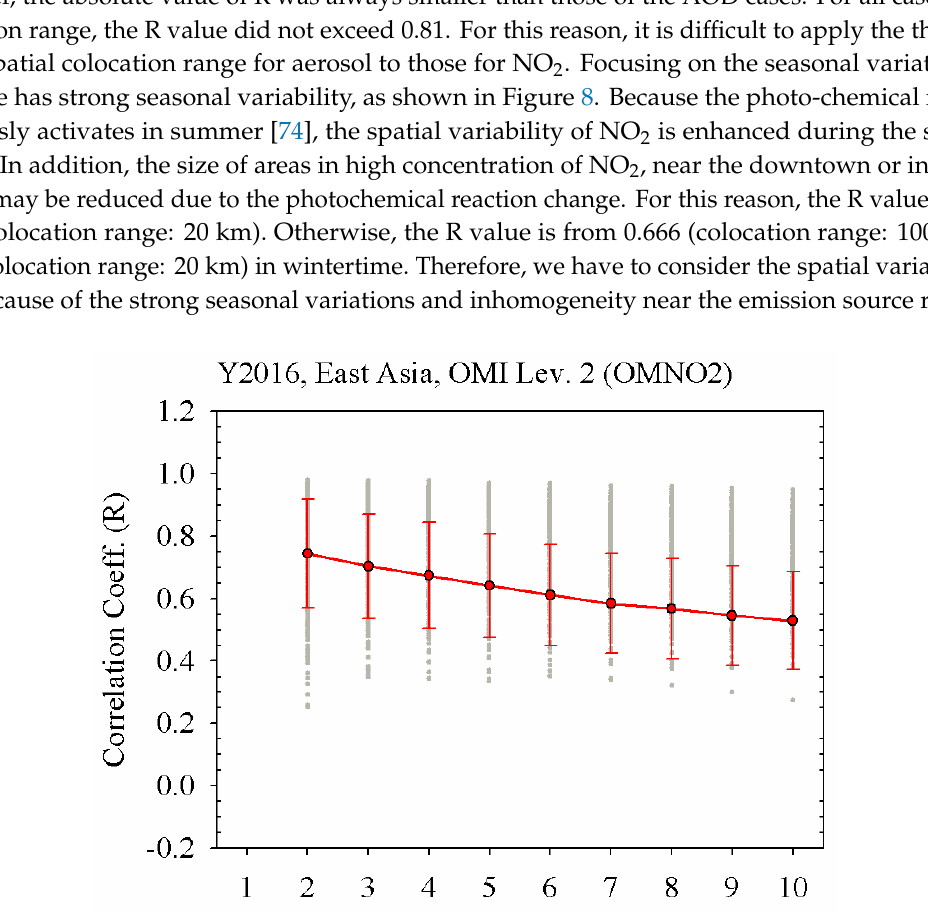
Figure 8. Distribution of correlation coefficient (R d ) for TCN in East Asia with respect to the colocation range in ( a ) spring, ( b ) summer, ( c ) autumn, and ( d ) winter.